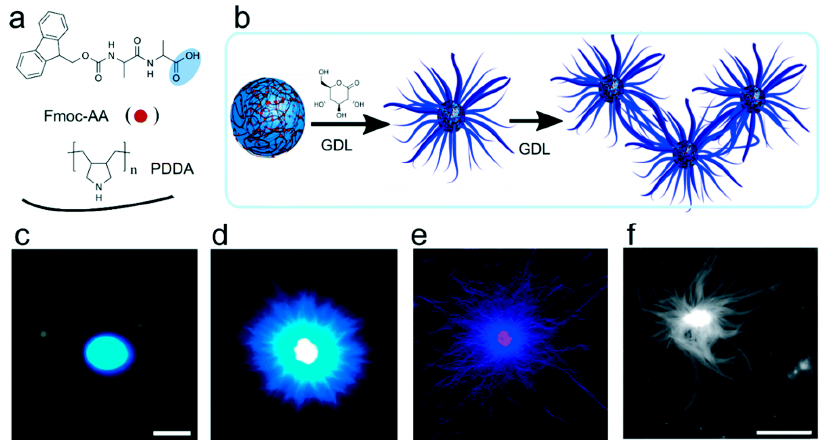
Figure 13. Chemical structures, schematic illustration, and microscopic images for the metamorphosis of coacervates–protocells to hydrogel, ( a ) chemical structures of dipeptide/polymer coacervate microdroplets prepared at pH 8.5, ( b ) schematic illustration of reconfiguration to aster-like core– shell microstructure at pH 4.5, ( c , d ) PDDA/Fmoc-AA coacervates before and after addition of GDL (Glucono delta Lactone) and sequestered with Hoechst 33,258 fluorescent. This change from coacervates to nanofibers is induced due to the slow hydrolysis of GDL in the coacervates phase, ( e ) PDDA/Fmoc-AA coacervates core hydrogel sequestered with 1 mol% RITC-labelled PAH, ( f ) AFM images of nanofibrous gel. Reprinted from Chemical Science 2016, 7, 5879–5887.Copyright 2016 Royal Society of Chemistry.